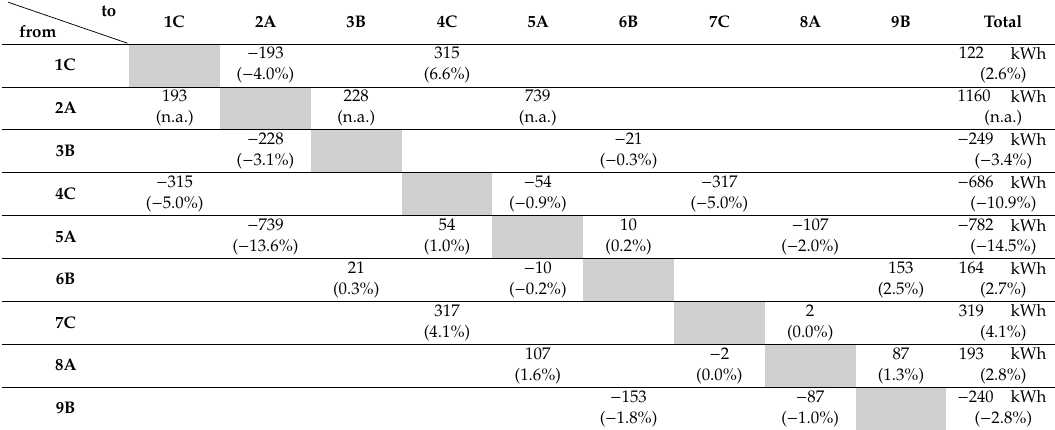
Table 7. Share* of heat given or stolen between adjacent apartments, scenario b, kWh and (%). to